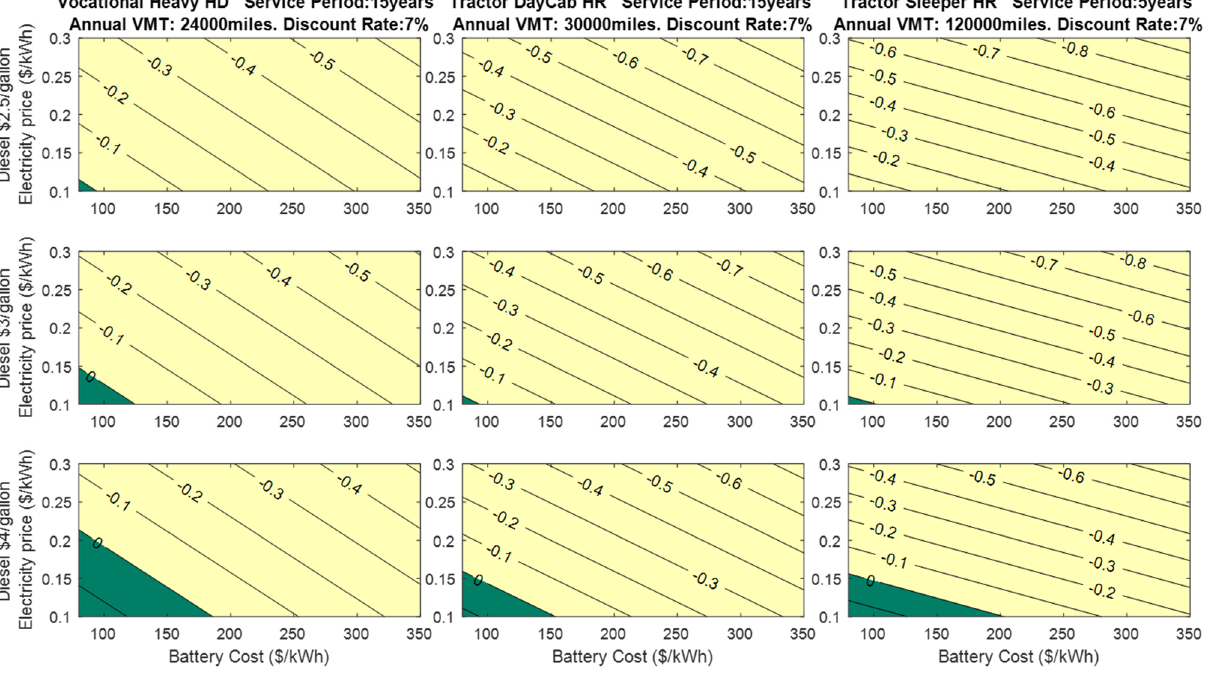
Figure 4. Difference in TCO in using heavy duty electric truck for various vocations.